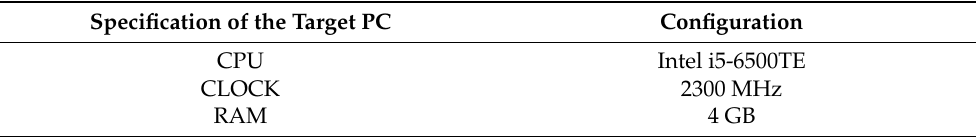
Table 4. Specification of the target PC